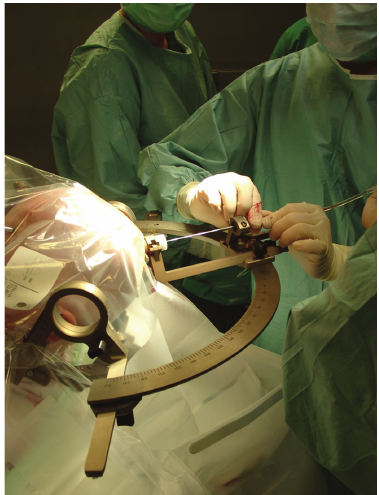
Figure 3: Intraoperative circumstances during intracranial stereo- taxy for taking a brain tumor biopsy (using a Leksell Stereotactic